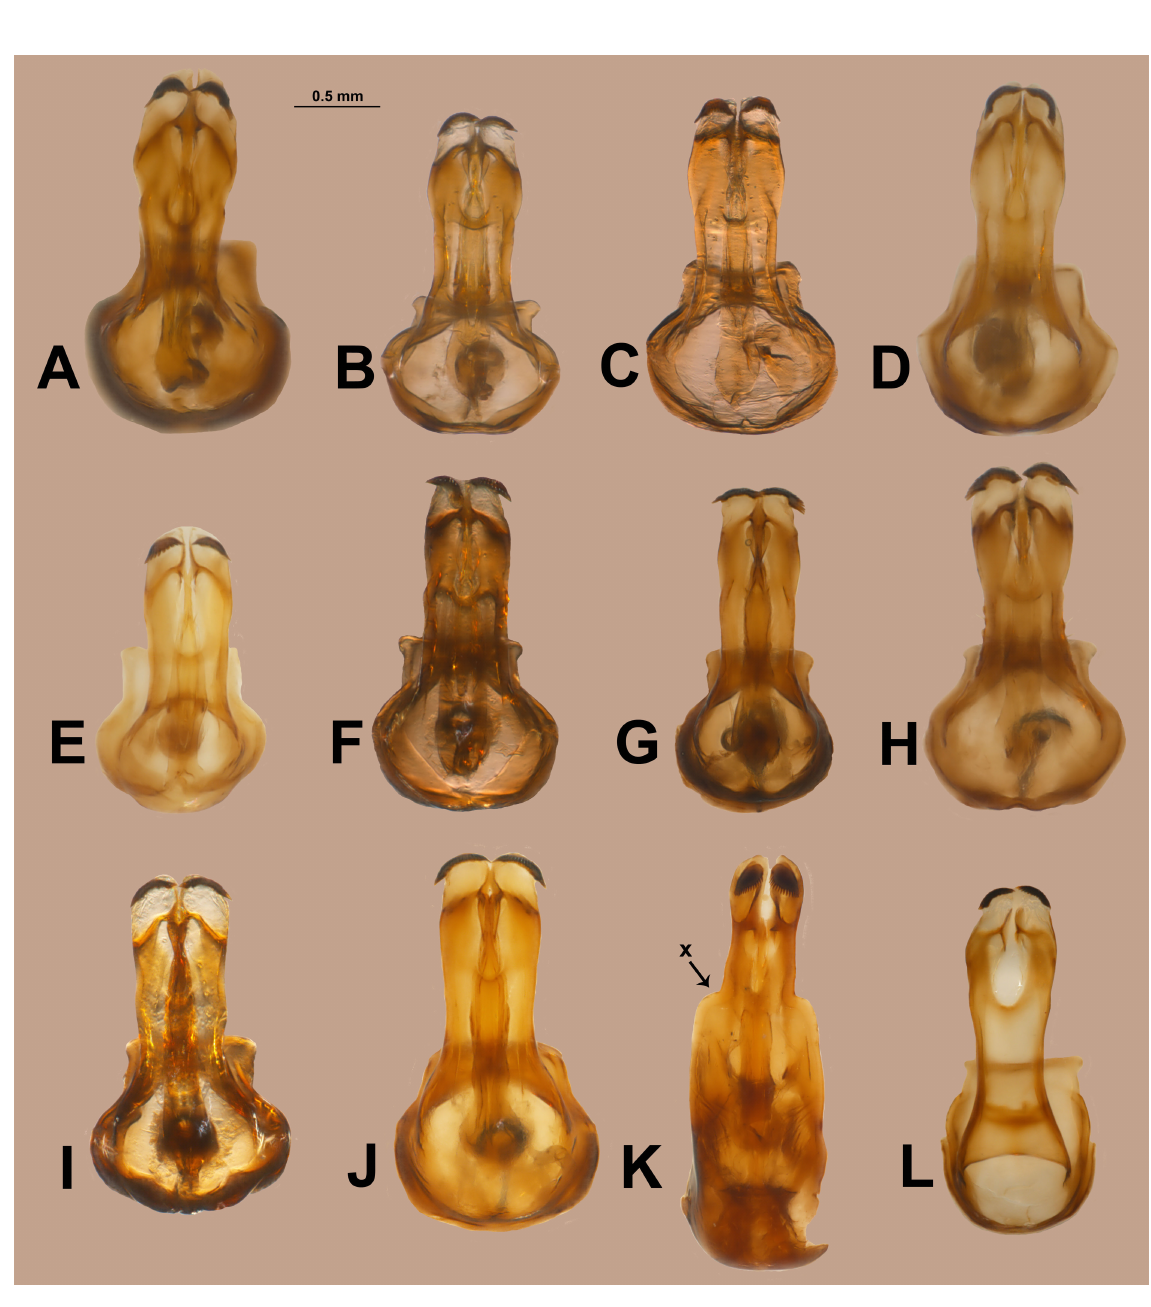
Fig. 12. Megatrigon spp., ♂ terminalia, hypandrium, ventral view. A . Megatrigon argenteus (Walker, 1852) comb. nov. B . M. argentifrons sp. nov. C . M. argentimaculatus sp. nov. D . M. magnicornis sp. nov. E . M. natalensis sp. nov. F . M. apiformis sp. nov. G . M. cooksoni sp. nov. H . M. immaculatus sp. nov. I . M. ochreatus (Hull, 1964) comb. nov. J . M. tabanoides sp. nov. K . Megatrigon sp . from the sexfasciatus group. L . M. nivalis (Hull, 1964) comb. nov. Symbol: x = lateral